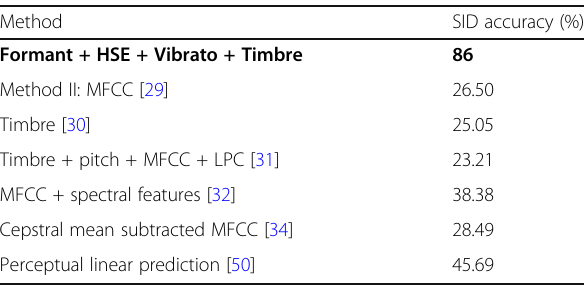
Table 7 Performance evaluation of existing Indian SID systems (results are tested using our database of 26 singers with maximum song duration of 9